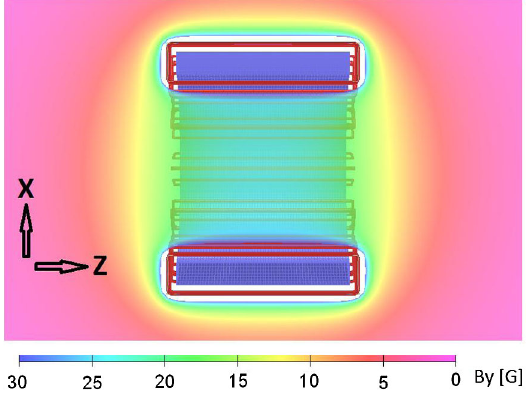
FIG. 3. Bending field on the middle cross section Z - X plane. (The B y contours are not shown inside the ferrite